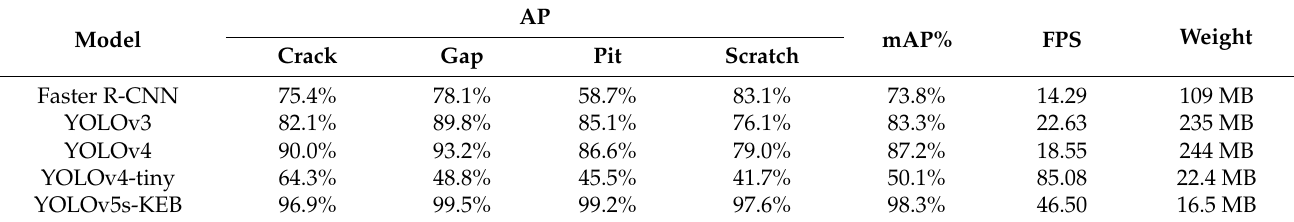
Table 5. Comparison of detection performance for different